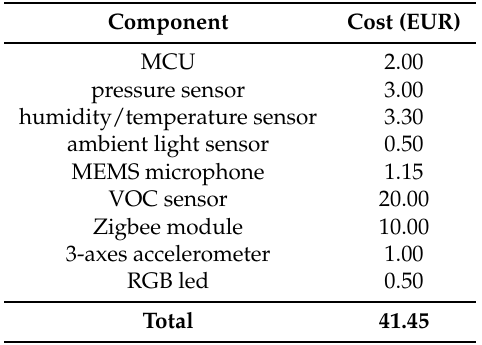
Table 1. Core component list and costs (as of May 2018) for prototype sensor node.